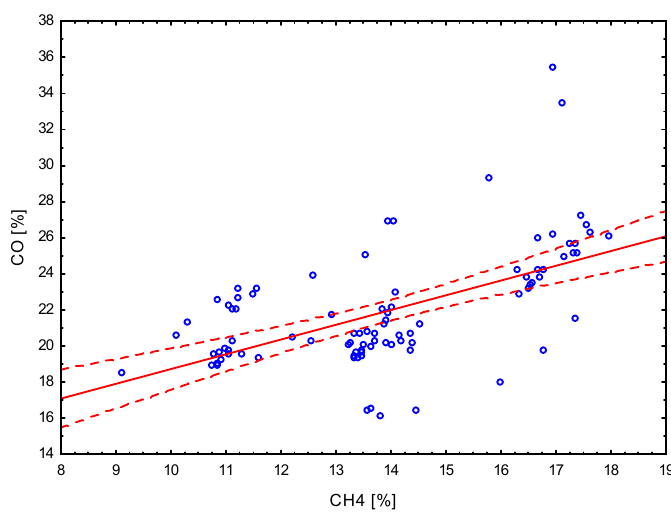
Figure 7. Correlation between percentage content of CO and percentage content of CH 4 .